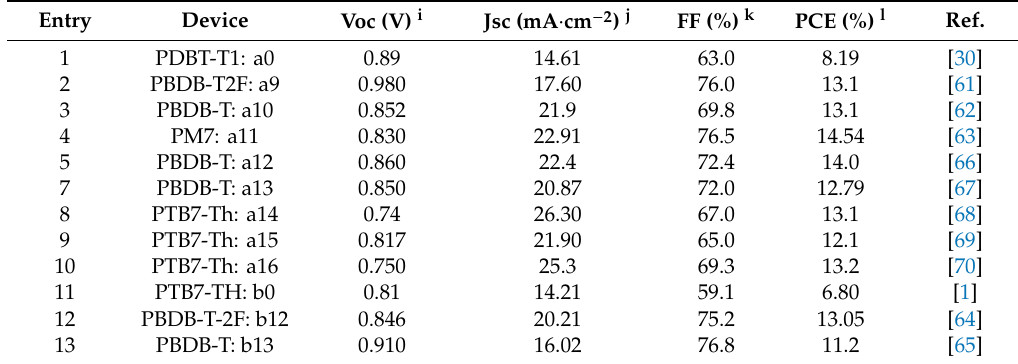
Table 6. Photovoltaic properties of the best devices incorporating NFA acceptors shown in Figure